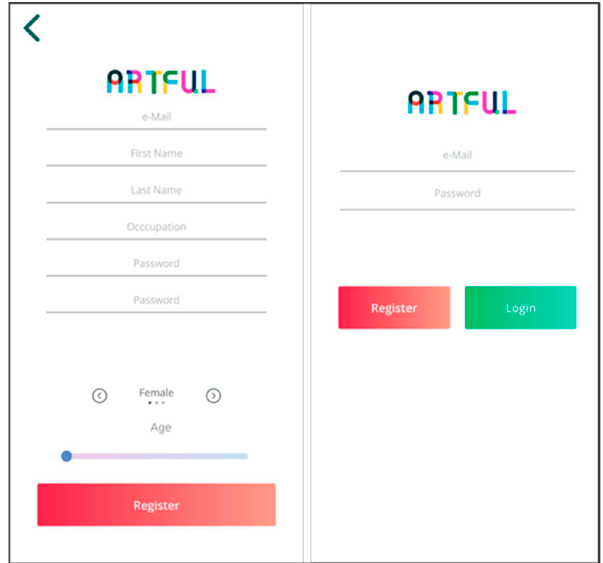
Figure 4. ARtful mobile app’s technological framework. Figure 4. ARtful’s mobile app registration